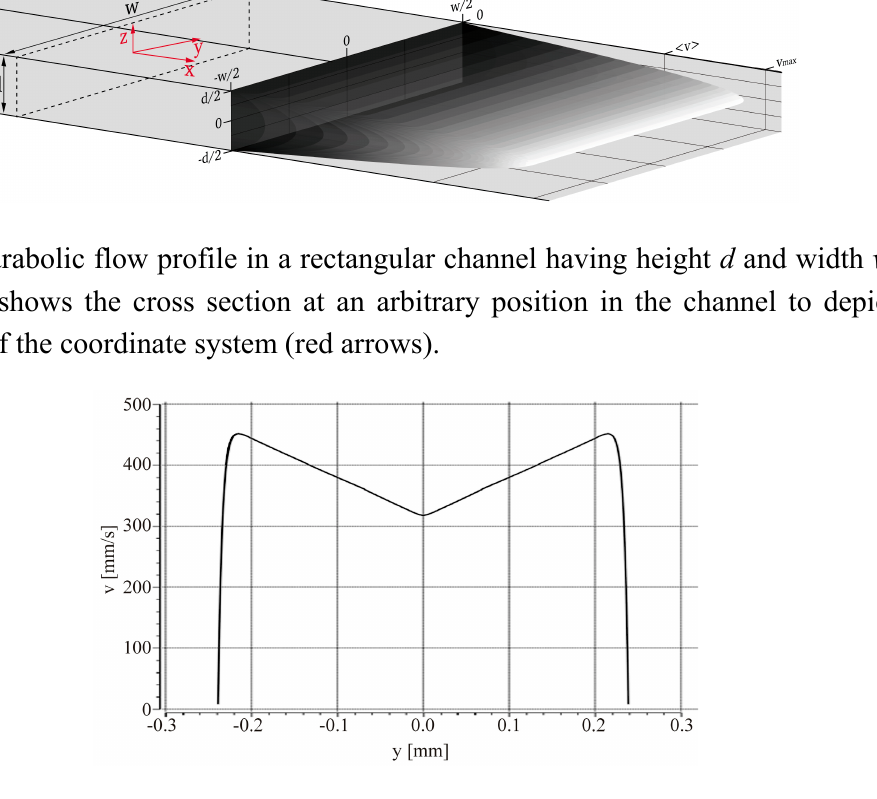
Figure 7. Simulation of the channel bottom deflection, approximated with a triangle. The simulation shows that, in contrast to the flow profile of a perfect rectangular cross section, the velocity is dependent on y over the total channel width w . The velocity profile corresponds to a horizontal cut through the middle of the channel at position y =